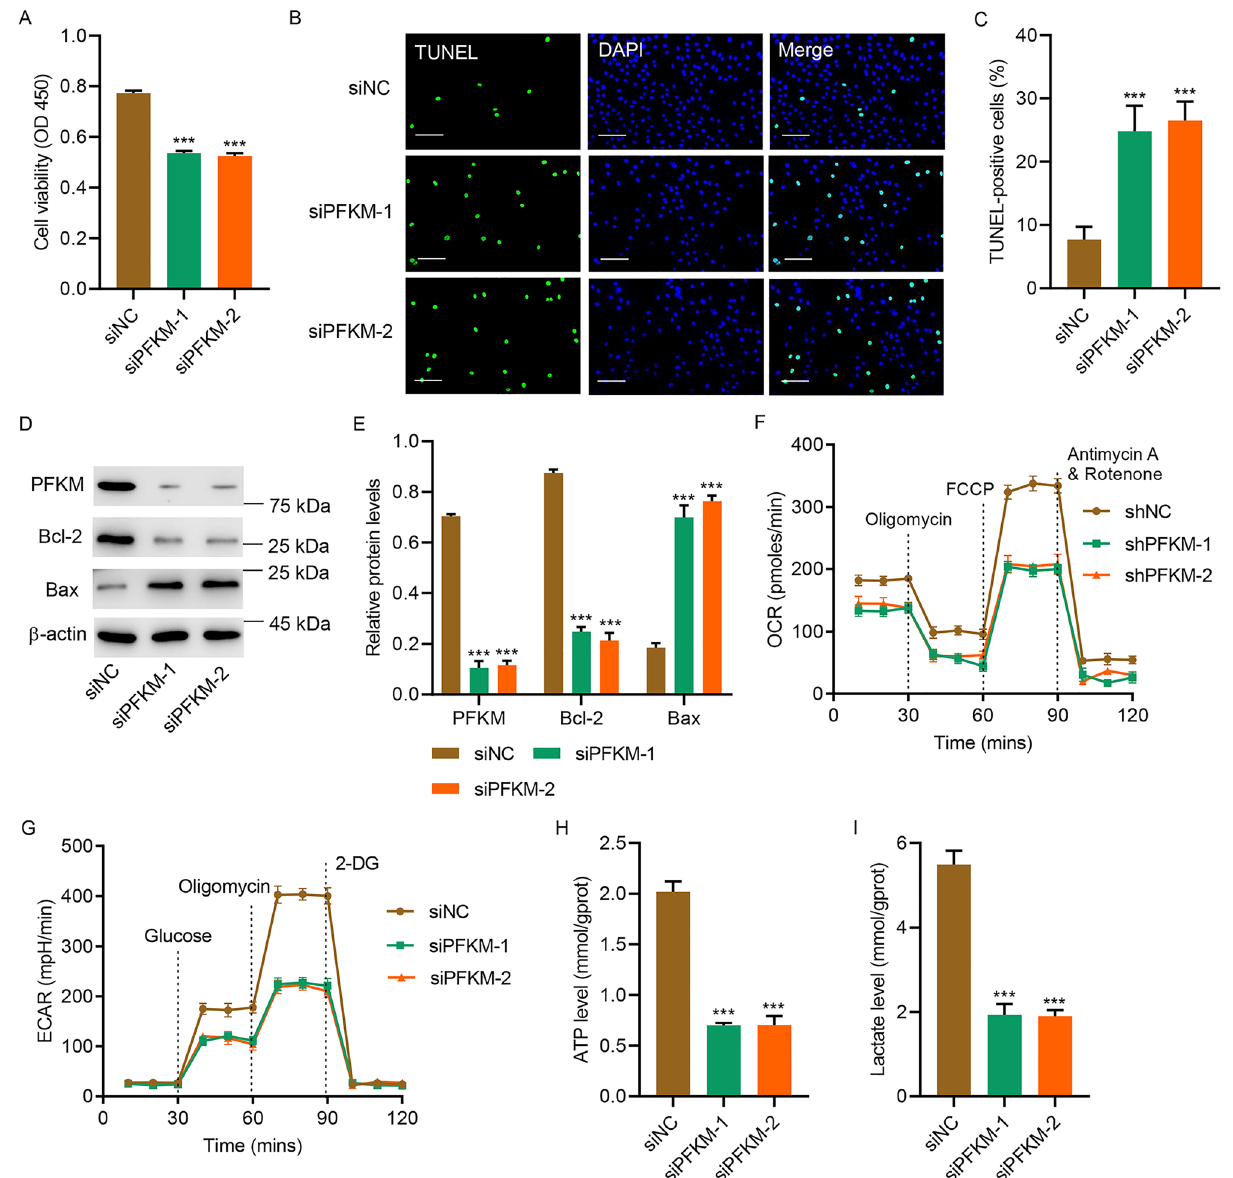
Figure 3. PFKM downregulation promoted cell apoptosis and inhibited OXPHOS and glycolysis. H9c2 cells were transfected with PFKM siRNA or siNC, and ( A ) cell viability, ( B , C ) TUNEL staining, ( D , E ) expression of PFKM, Bcl-2 and Bax, ( F ) OCR, ( G ) ECAR, ( H ) ATP and ( I ) lactate level were measured. Scale bar: 100 μm. ***P < 0.001 vs siNC. (see Supplementary Fig. S9–S12, more information for Supplementary Fig. S12 can be found in Supplementary Information